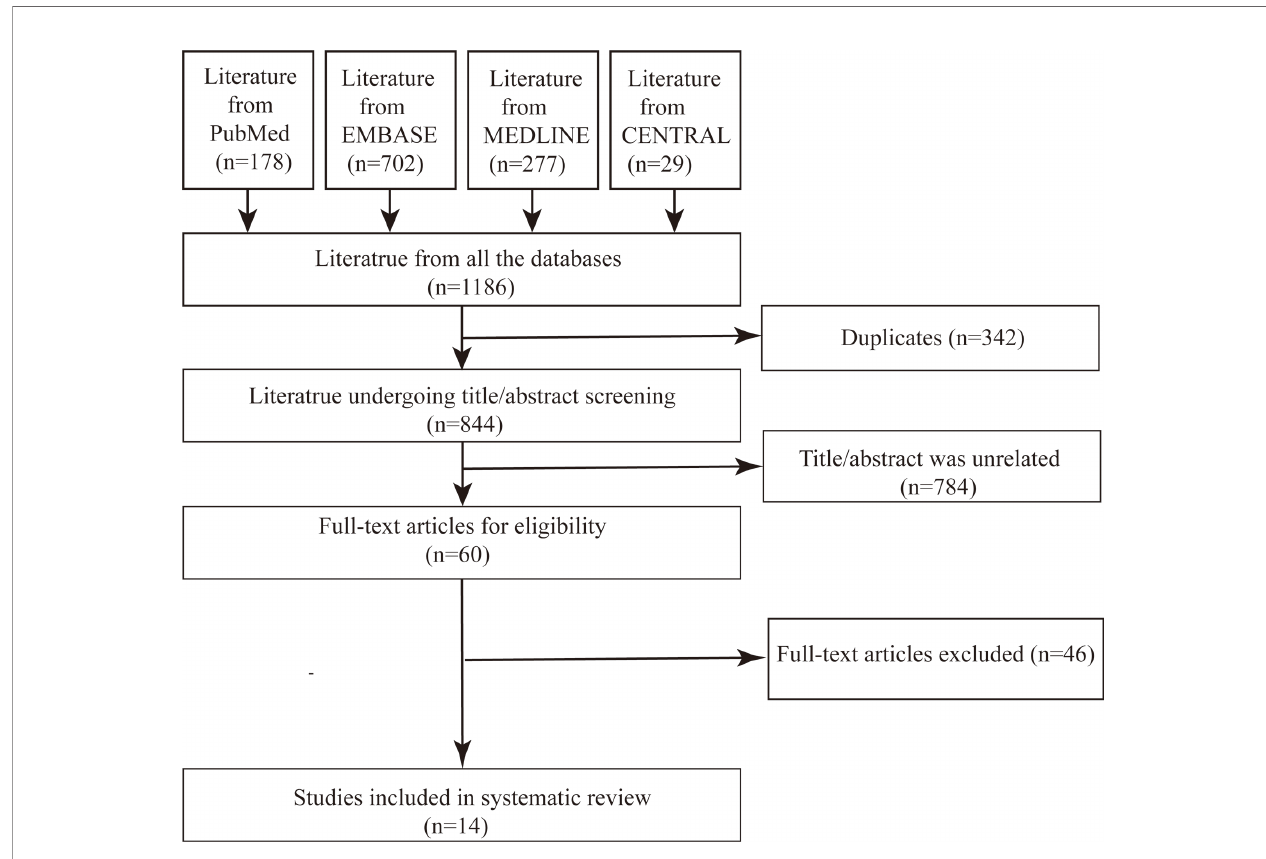
FIGURE 1 | Flow diagram detailing the search strategy and